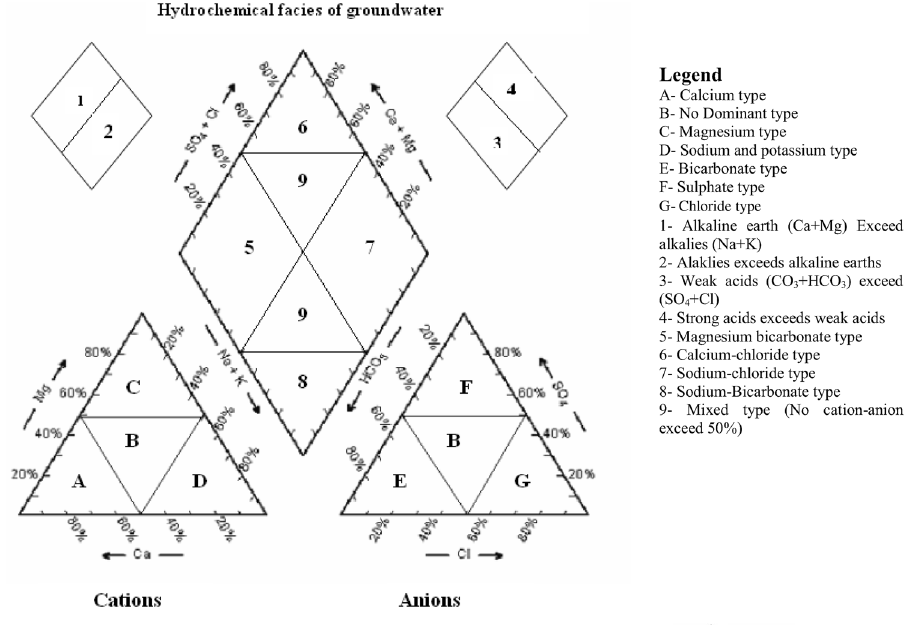
Fig. 2 Piper-trilinear diagram presenting anion and cation facies in the form of major ion percentages. Groundwater types are classified according to the domain in which they occur on the diagram segments (after Sadashivaiah et al.